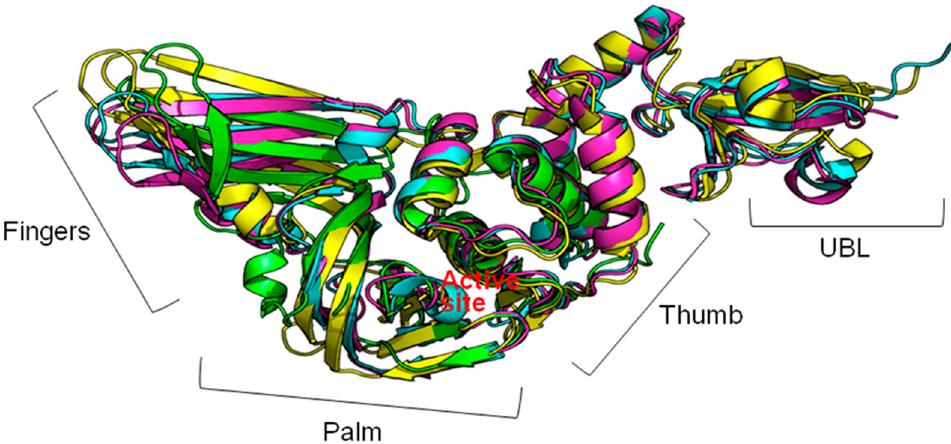
Figure 2. The figure shows the structures aligned in PyMOL of transmissible gastroenteritis virus (TGEV) PLpro (Protein Data Bank Identifier (PDB ID): 3MP2; green), Middle East respiratory syndrome CoV (MERS-CoV) PLpro (PDB: 4P16; yellow), severe acute respiratory syndrome coronavirus (SARS-CoV) PLpro (PDB: 2FE8; blue), and SARS-CoV-2 PLpro (PDB: 6W9C; pink); UBL—ubiquitin-like domain.